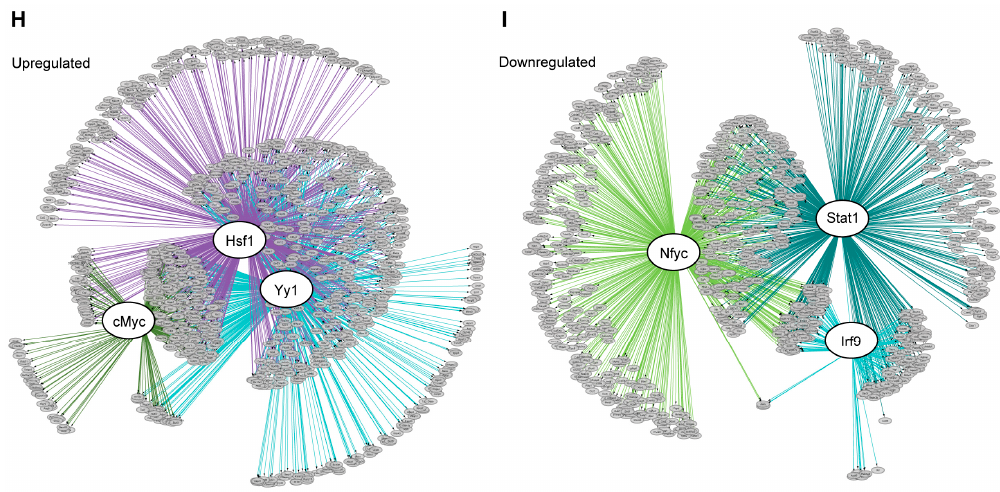
Figure 1. Identification of gene regulatory networks linking FUT9 expression to stemness in glyco-engineered colon cancer cells. ( A ) RT-PCR-based assessment of mRNA levels of murine fucosyltransferases (FUT) upon transcriptional activation of the Fut9 gene in MC38 cells using the CRISPR-dCas9-VPR technology. Expression was normalized to the housekeeping gene Gapdh ( M. musculus ). Di ff erences (fold change) relative to MC38-MOCK cells are depicted in triplicates. Data representative of two independent experiments. ( B ) Western blot analysis for FUT9 in MC38-glycovariants. Data representative of two independent experiments. ( C ) Flow cytometric analysis of the Lewis x expression on the surface of MC38 glyco-engineered cells. Histograms representative of two independent experiments. ( D ) Representative images of anti-Lewis x immunofluorescence staining in MC38-MOCK and MC38-FUT9 cells. DAPI staining represents nucleic acid (nuclear) staining. Scale bar 10 µ m. ( E ) Venn diagram depicting the number of di ff erentially expressed genes (DEGs) between MC38-WT vs. MC38-MOCK and MC38-FUT9 vs. MC38-MOCK cells identified by RNA-seq analysis. In MC38-FUT9 cells compared to MC38-MOCK cells, 1709 genes were upregulated and 1874 genes were downregulated. ( F ) The top 3 of the predicted transcription factors (TFs) identified by the RNA-seq-based regulon analysis (iRegulon) corresponding to the upregulated genes (top panel) and the downregulated genes (lower panel) in MC38-FUT9 cells. NES represents the normalized enrichment score. The number of the predicted direct targets among DEGs and the significantly enriched motifs corresponding to each regulator is provided in the table. More details on the motifs and TF-associated genes can be found in Tables S2–S5. ( G ) Normalized counts of the top regulators identified with iRegulon. Statistical significance was assessed using the Benjamini–Hochberg false discovery rate (FDR) < 0.05 (* p < 0.05, ** p < 0.01 and *** p < 0.001). ( H , I ) Regulatory networks for the upregulated ( H ) and downregulated ( I ) genes found in MC38-FUT9 cells reveal a strong overlap among the regulons and the predicted TFs. Direct targets (DEGs) are in grey circle nodes and TFs in white circle nodes. Regulons for each TF are represented by the di ff erent line colors. # indicates the gRNA